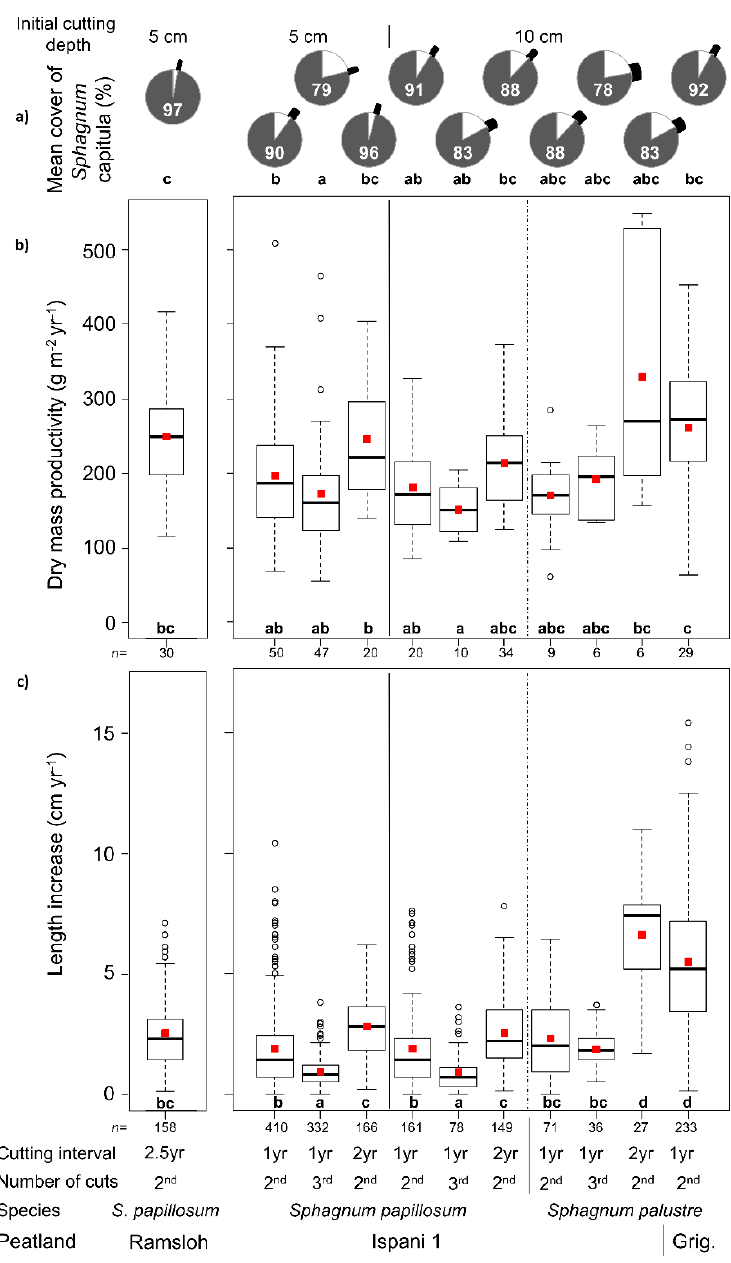
Figure 5. Regrowth of S. papillosum and S. palustre expressed as a) mean cover of Sphagnum capitula directly before cutting (the black strip adjacent to each pie chart is the 95 % confidence interval), b) dry mass productivity and c) length increase, for treatments with different combinations of initial cutting depth (5, 10 cm), cutting interval (1, 2 years) and number of cuts (second or third cut) at the Ramsloh Sphagnum farming field in Germany (Sep 2008–Mar 2011), and at Ispani 1 (Apr 2007–Mar 2009) and Grigoleti (Apr 2008–Mar 2009) in Georgia. n = number of measurements (on 10 × 10 cm sampling squares); a) and b) have the same numbers of measurements. The ‘box and whisker’ graphs in b) and c) show the median (bold line), the mean (red square), the upper and lower quartiles (which include 50 % of the data and create the box), whiskers representing the lowest value within 1.5 IQR (= interquartile range) of the lower quartile and the highest value within 1.5 IQR of the upper quartile, and outliers (o, i.e . values outside these ranges). Values with different letters differ significantly ( P ≤ 0.05). Differences between sites (peatlands), treatments and species were analysed using the non-parametric Kruskal Wallis test after Siegel & Castellan (1988) after a significant overall Kruskal Wallis test for a) cover of Sphagnum capitula: χ² = 84.1081, df = 10, P -value <0.001; b) biomass: χ² = 59.3225, df = 10, P -value < 0.001; c) length: χ² = 735.6477, df = 10, P -value <